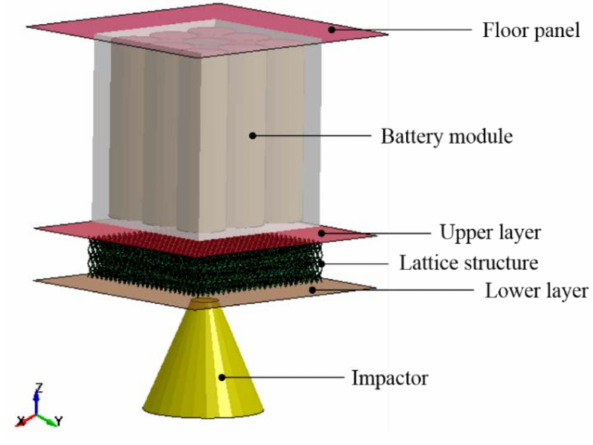
Figure 1. Numerical simulation model.